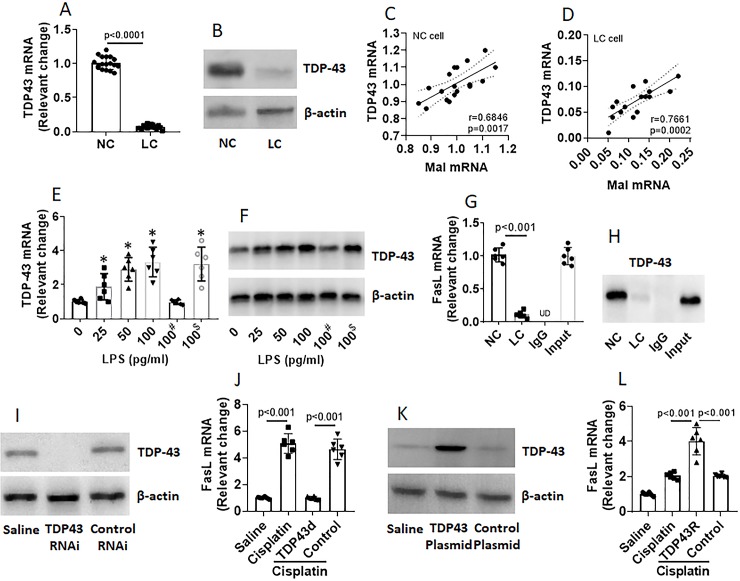
Activation of Mal modulates TDP-43 expression.A-B, lung cancer (LC) tissue was collected from LC patients (n = 18). LC cells and NC cells were isolated from the tissue and analyzed by RT-qPCR and Western blotting. Bars indicate the levels of TDP-43 mRNA (A) and immunoblots indicate TDP-43 protein (B). C-D, scatter dot blots indicate a positive correlation between TDP-43 and Mal in NC and LC cells. E-F, NC cells were cultured in the presence of LPS at indicated concentrations (denoted on the x axis of E) for 48 h. Bars indicate the mRNA levels of TDP-43. Immunoblots indicate the protein levels of TDP-43. G-H, HC cells and LC cells were prepared and analyzed by RNA-immunoprecipitation assay; a complex of FasL mRNA and TDP-43 protein was identified. Bars indicate FasL mRNA in the complex. Immunoblots indicate TDP-43 protein in the complex. I, results of TDP-43 RNAi. J, NC cells (with or without TDP-43 depletion) were exposed to cisplatin in the culture for 48 h. Bars show FasL mRNA expression in EC cells. K, results of TDP-43 restoration by transfection of TDP-43 expressing plasmids (TDP-43R). L, Bars show FasL mRNA expression in LC cells. Data of bars are presented as mean ± SEM. Each dot in bars presents data obtained from one sample. Statistics: A and G, t test. E, ANOVA: p<0.0001; *p<0.01, compared with the group “0” (Bonferroni test). J and L, ANOVA + Dunnett’s test. Data of B represent 6 independent experiments (protein extracts of 18 samples were pooled). Data E-H represent 6 independent experiments. #, cells were treated with Mal RNAi to knock down the expression of Mal. $, cells were treated with control RNAi.